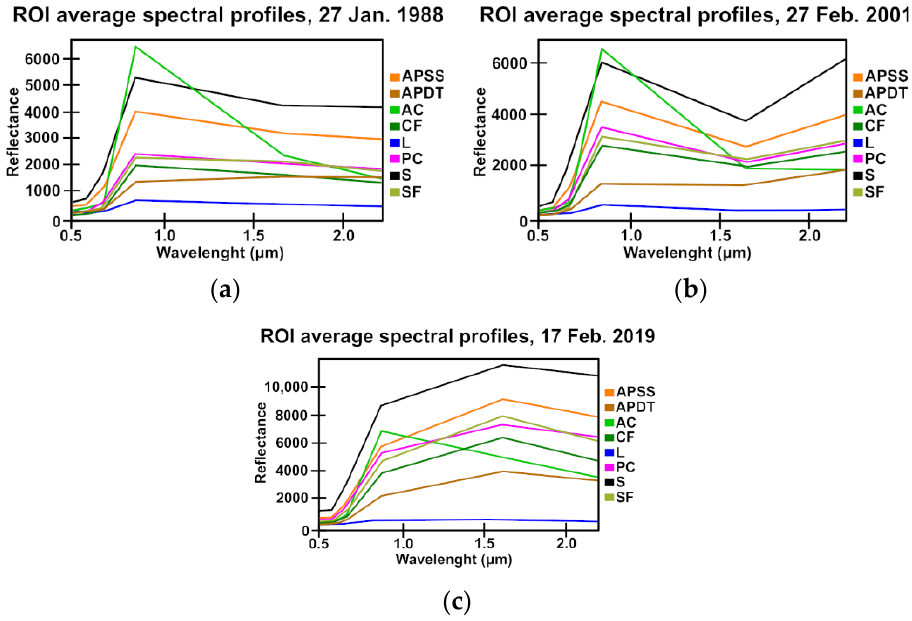
Figure 4. AC = autumn crops, APSDT = arable lands ‐ pastures on soils with a different texture, APSS = arable lands ‐ pastures on sandy soils, CF = compact forests, L = lakes, PC = permanent crops, S = sands, SF = scattered forests.